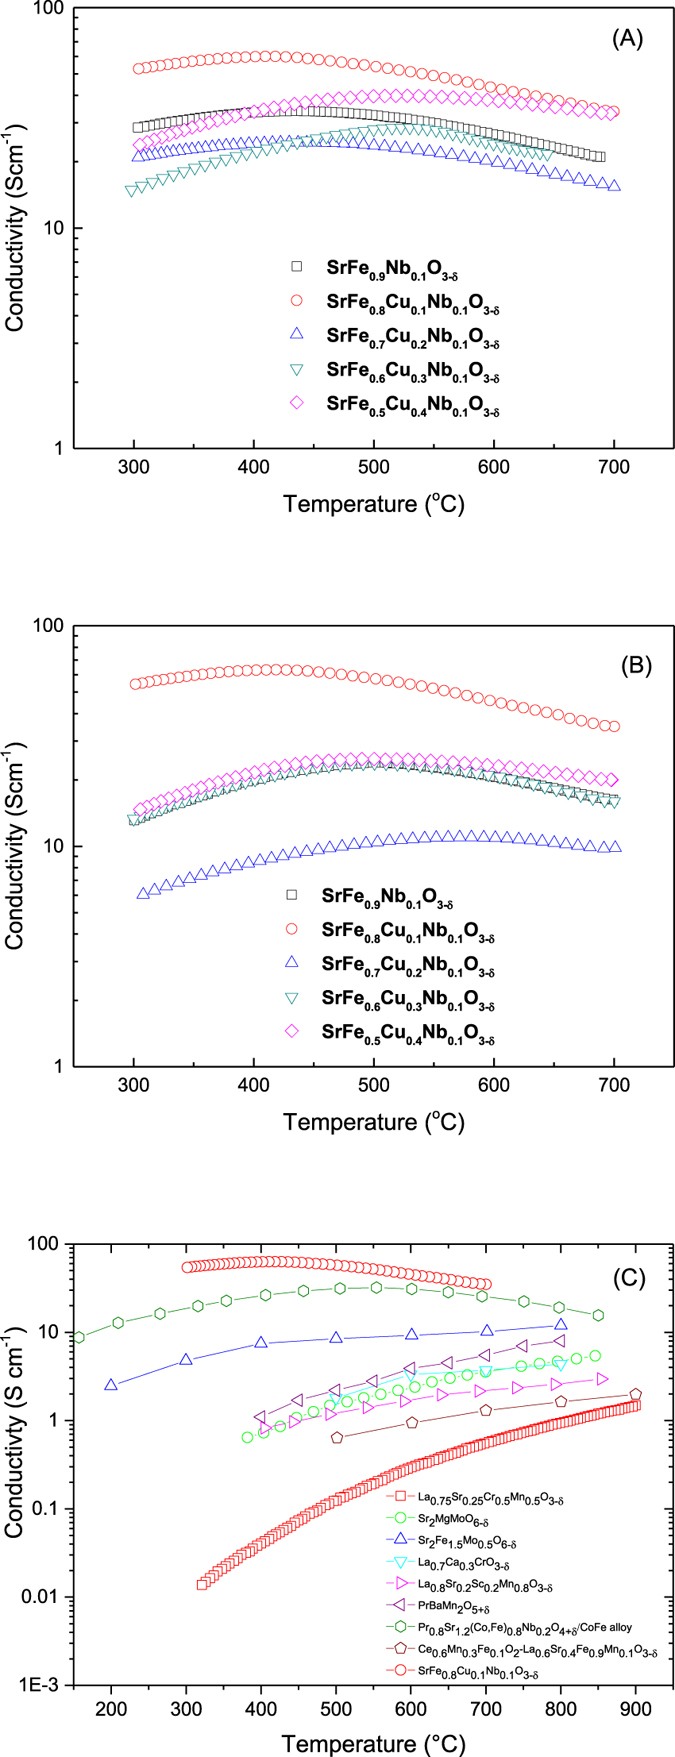
Conductivity of SrFe0.9−xCuxNb0.1O3−δ (x = 0–0.4) in air (A) 5% H2/Ar (B) and comparison of conductivities of reported anode materials in H2 or 5%H2 (C).